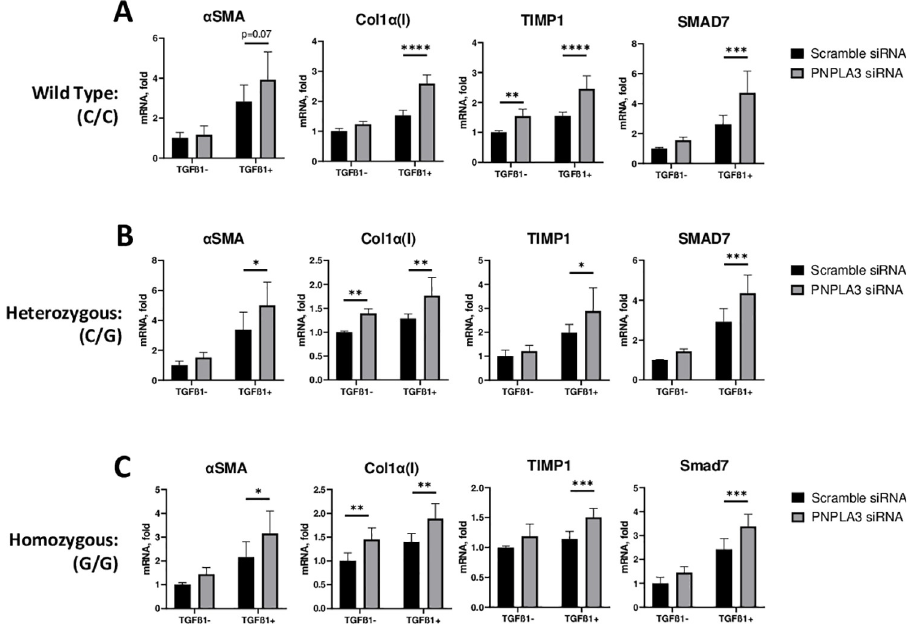
Fig 2. PNPLA3 knockdown activates primary human HSCs regardless of rs738409 genotype. Primary HSCs were treated with control 5nM scrambled or PNPLA3 siRNA (Ambion) followed by treatment with or without 5ng/ml TGF- β and cultured for 24 hours. Expression of α -SMA, collagen 1, TIMP1, and SMAD7 in wildtype (A), heterozygous (B), and homozygous (C) donors was determined by qPCR. Values are mean +/- SD; � p < 0.05 �� p < 0.01 ��� p < .001 by 2-way ANOVA vs scramble siRNA. n = 5–6.